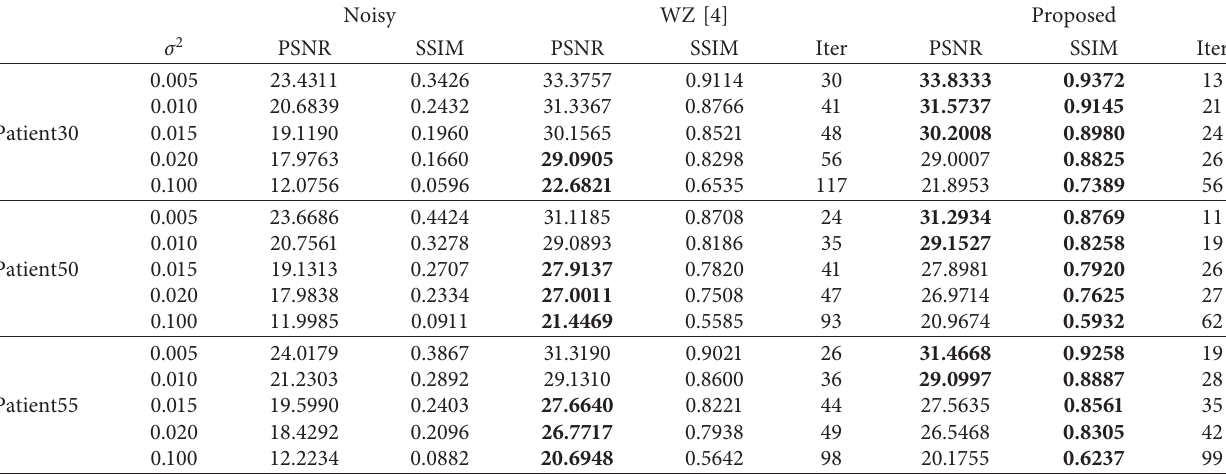
Table 1: PSNR and SSIM values of the images in Figure 1 affected by different values of Gaussian noise σ 2 and their corresponding iteration number for both functions.